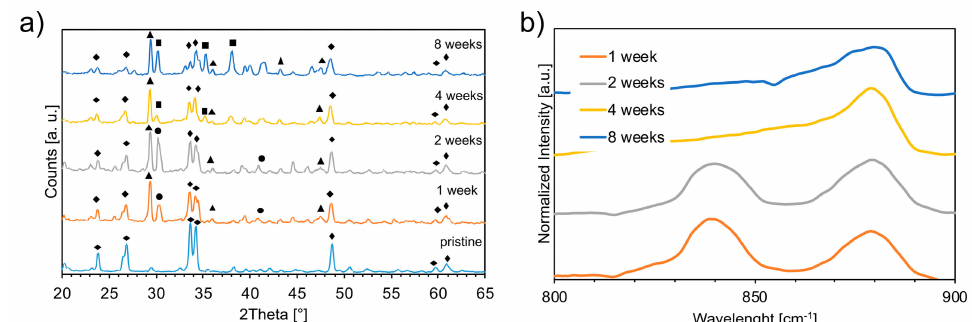
Figure 2. ( a ) XRD patterns of unaged foam and aged foams at di ff erent time points: 1, 2, 4, and 8 weeks. ( (cid:4) ) = Na 2 CO 3 (PDS 37-0451 and PDS 19-1130); ( (cid:8) ) = NaHCO 3 (PDS 15-0700); ( (cid:78) ) = CaCO 3 (PDS 01-837, PDS 83-0577, PDS 85-1108); ( (cid:117) ) = Na 2 Ca 2 Si 3 O 9 (PDS 75-1686 Combeite). ( b ) Normalized curves obtained by MIR spectroscopy on the same aged foams. The peak at 840 cm − 1 corresponds to HCO 3 − , − while the one at 880 cm − 1 corresponds to CO 2 . The normalized intensity represents the ratio between 3 the sample reflected intensity and KBr reflected intensity. KBr powder, slightly pressed in a holder, was used as a reference [color figures